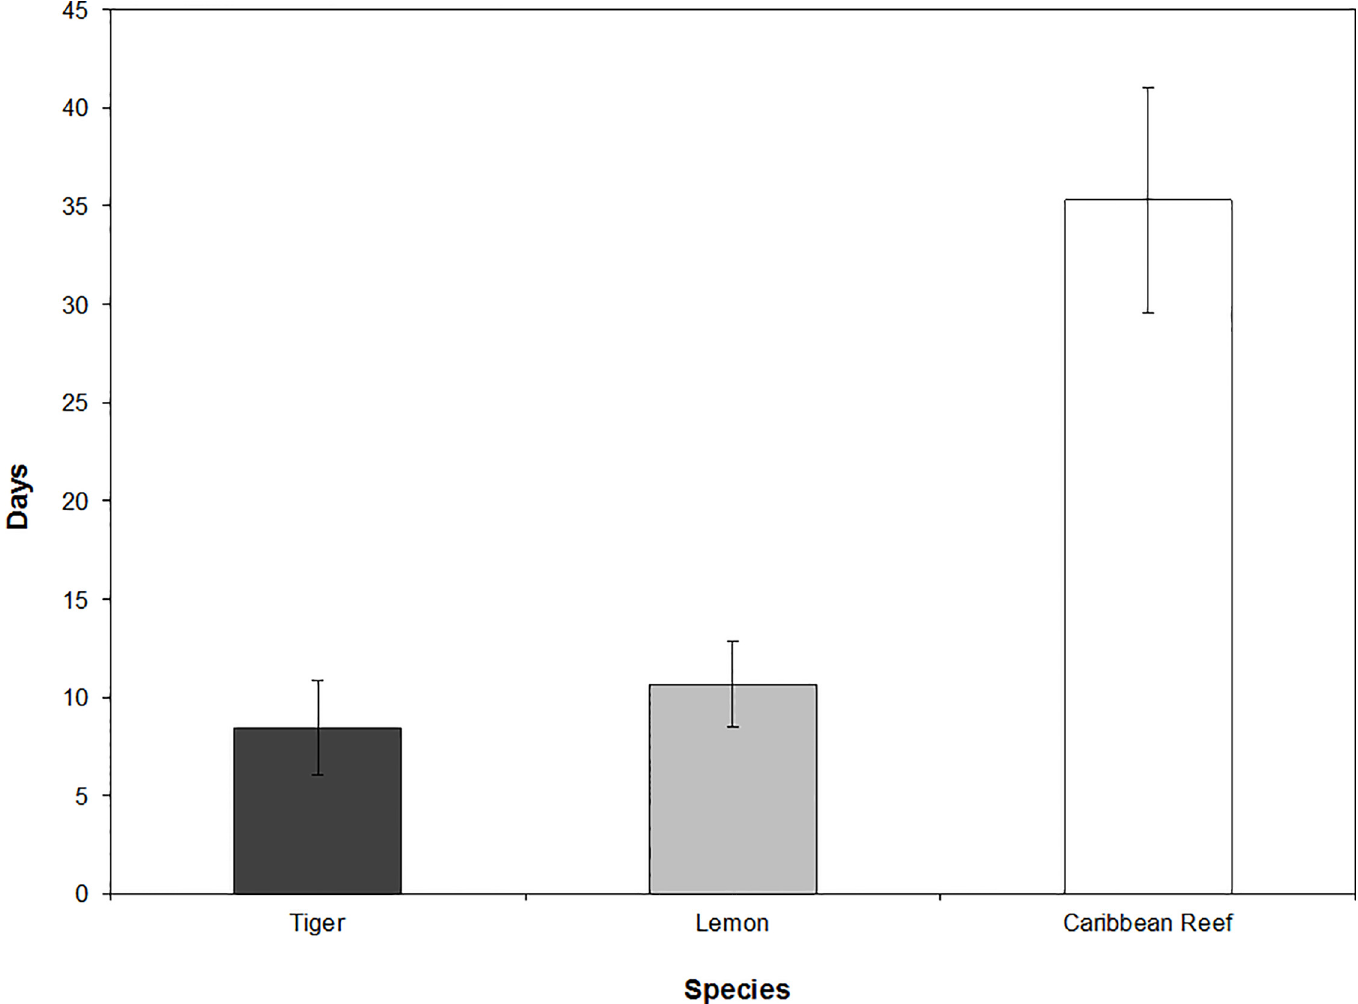
Fig 4. Average absence values for three species of sharks within MCE habitat monitored by the acoustic array. Absence value = average number of consecutive days not detected within the acoustic array for tiger (8.4 days), lemon (10.6 days), and Caribbean reef sharks (35.3 days). Bars represent means ± standard